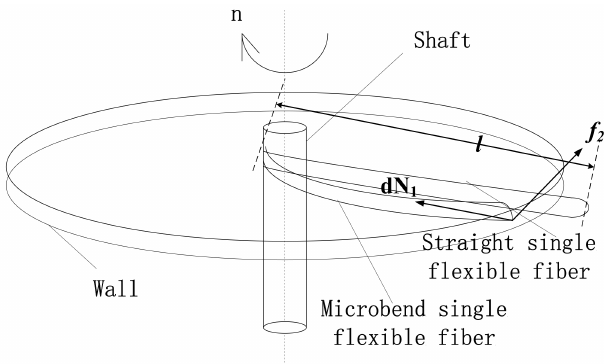
Figure 1. A single flexible blade radial force diagram.